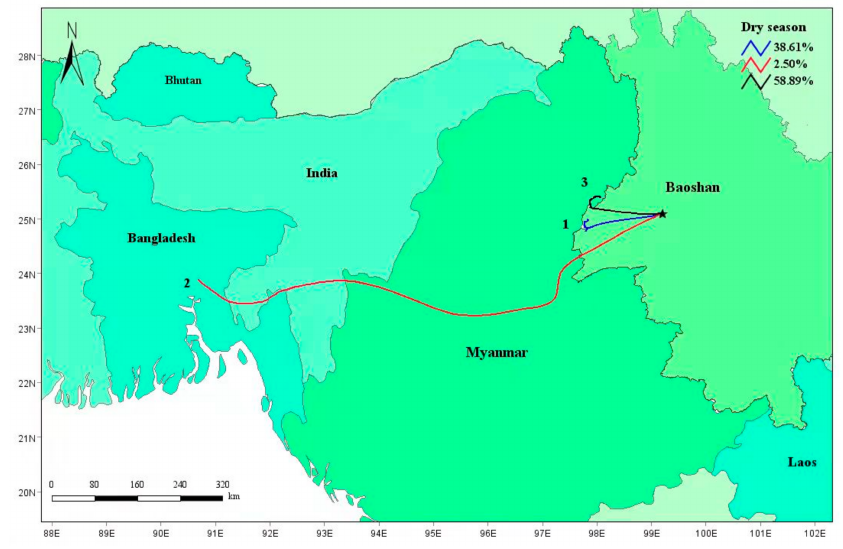
Figure 10. The mean 72 h backward trajectories of each trajectory cluster during the dry season and the percentage of allocation to each